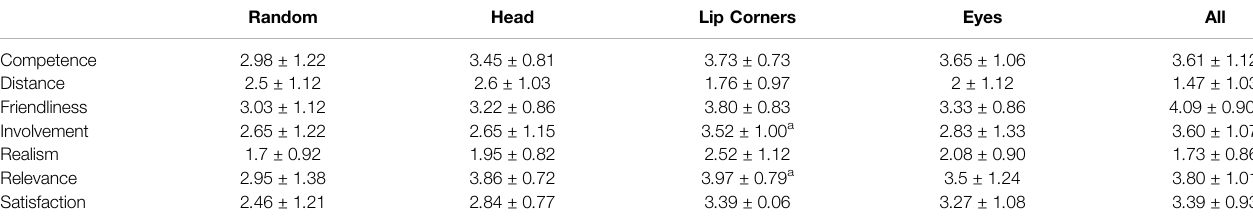
TABLE 4 | Mean ± standard deviation of each dimension of the questionnaires (each row of the table), for each of the fi ve conditions (each column). Random Head Lip